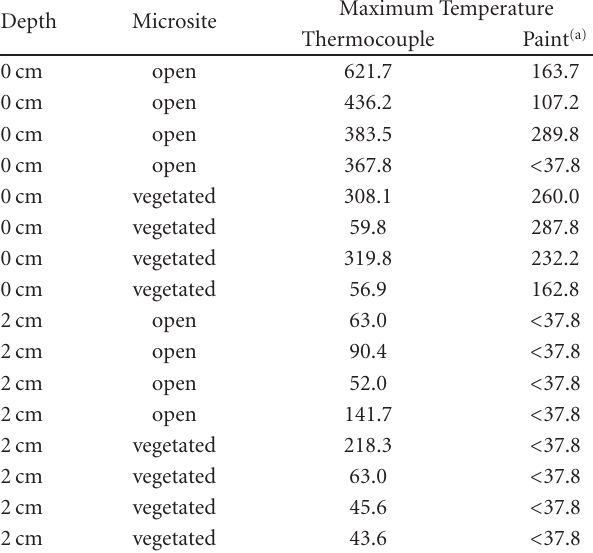
Table 5: Maximum temperatures at 0 cm and 2 cm soil depth, and in open and vegetated microsites, during a prescribed fire in sand pine scrub at Archbold Biological Station, Florida. Temperatures were quantified with copper-constantan thermocouples and with temperature-sensitive paints placed on adjacent glass petri dishes.